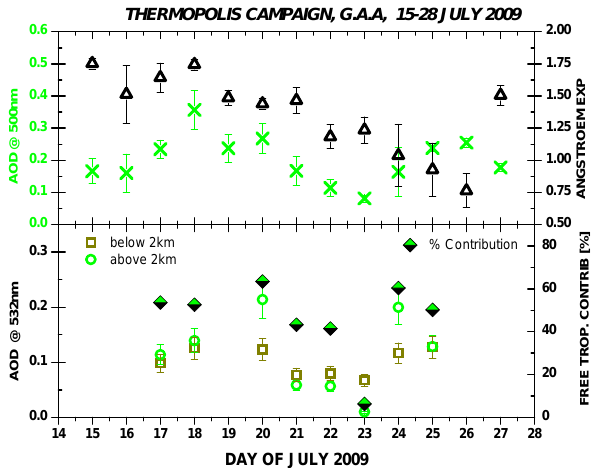
Fig. 1. Upper panel: AOD (crosses) and ˚Angst¨om exponent (triangles) derived by sun photometer over Athens from 15– 27 July 2009; Lower panel: AOD below (squares) and above (open dots) 2km height derived by Raman lidar measurements in the pe- riod 17–25 July 2009 (except on 19 July 2009) and the correspond- ing percentage of free troposphere (FT) aerosol contribution to the total aerosol optical depth (AOD).